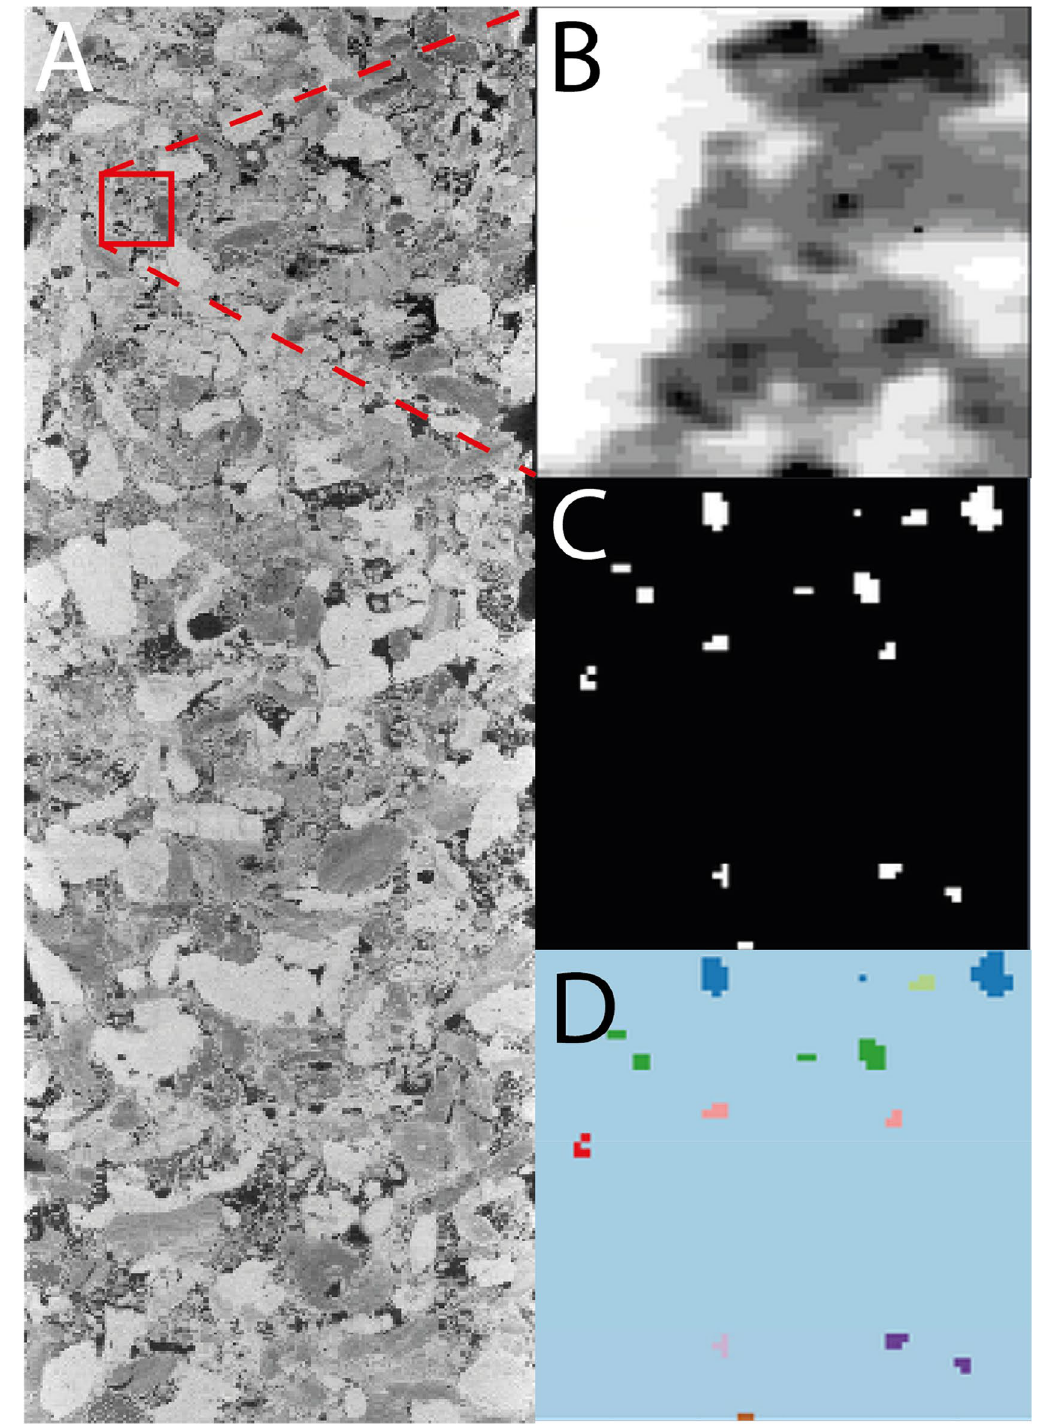
Figure 1. Labelling of the connected components of the primary porosity in a sub-volume of the Estaillades sample. ( A ) The raw micro-CT image, ( B ) the 15-phase segmentation of a sub volume extracted from the microCT image (red box), ( C ) the segmented primary porosity, and ( D ) the uniquely labelled connected primary porosity. Images in this figure were rendered using SciKitImage 45